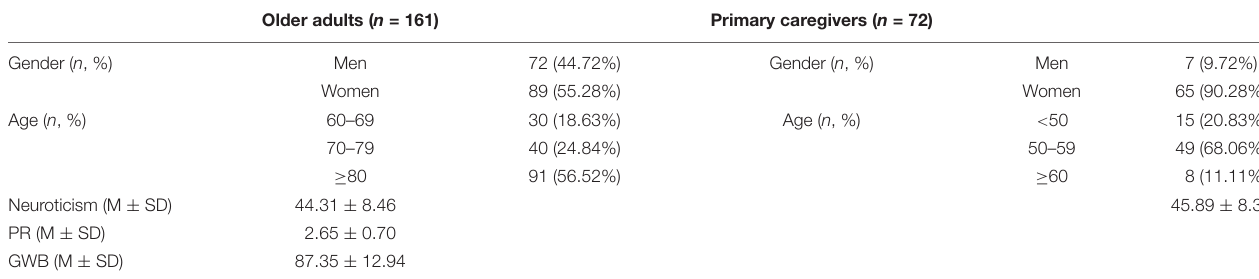
TABLE 1 | Participants characteristics, means, and standard deviations of study variables.